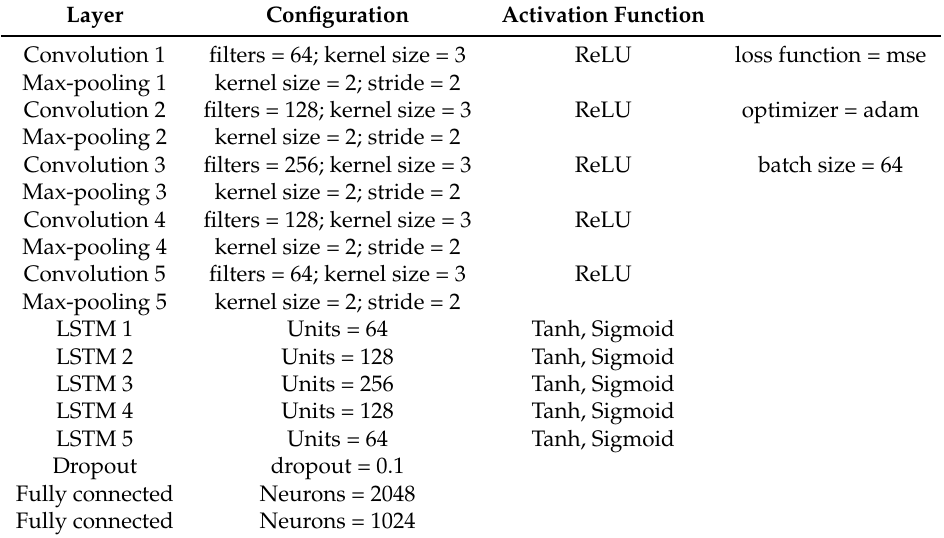
Table 1. Layer configuration of the proposed